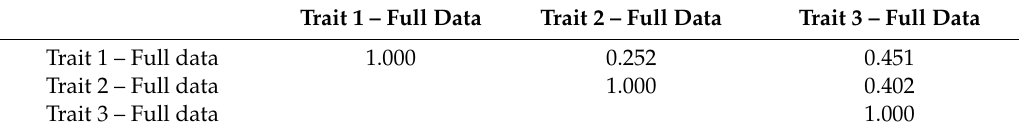
Table 3. Study 1: Expected Correlations Between Measures as Determined by Full Data.